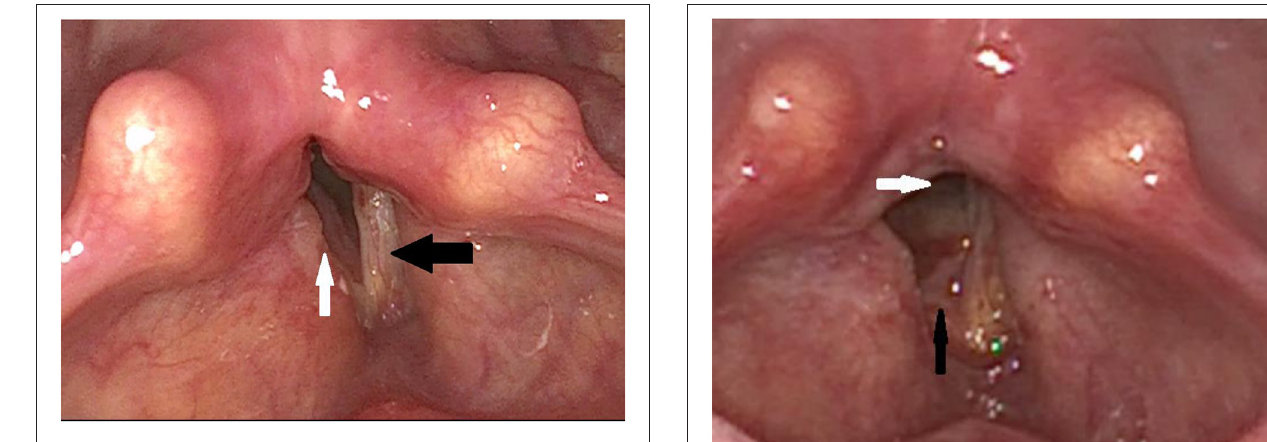
FIGURE 2 | Post-operative finding via laryngoscopy after laterofixation on the right side: The right vocal fold is fixed laterally (white arrow) and thus widens the glottic gap, while the position of the left vocal fold is unchanged (black arrow). The vestibular folds are less swollen.